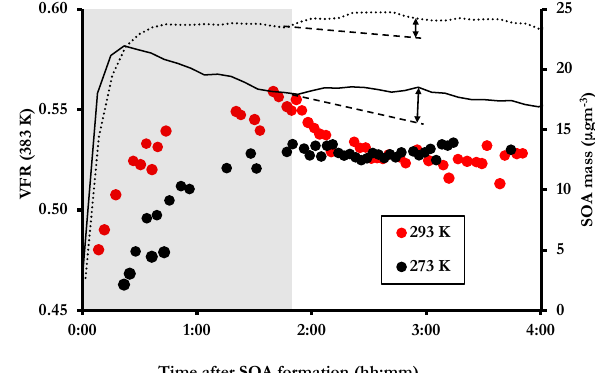
Fig. 9. Comparison of VFR (383K) for limonene SOA produced at 293K, SOA08-12 and 273K, SOA08-13. The white area indi- Fig. 9 Comparison of VFR (383 K) for limonene SOA produced at 293 K, SOA08-12 and 273 K, cates OH ageing. The uncorrected SOA mass 293K (solid line) and SOA08-13. The white area indicates OH ageing. The uncorrected SOA mass 293 K (solid line) and 273K (dotted line). The black arrows indicate SOA mass produced 273 K (dotted line). The black arrows indicate SOA mass produced from OH ageing in AIDA. from OH ageing in